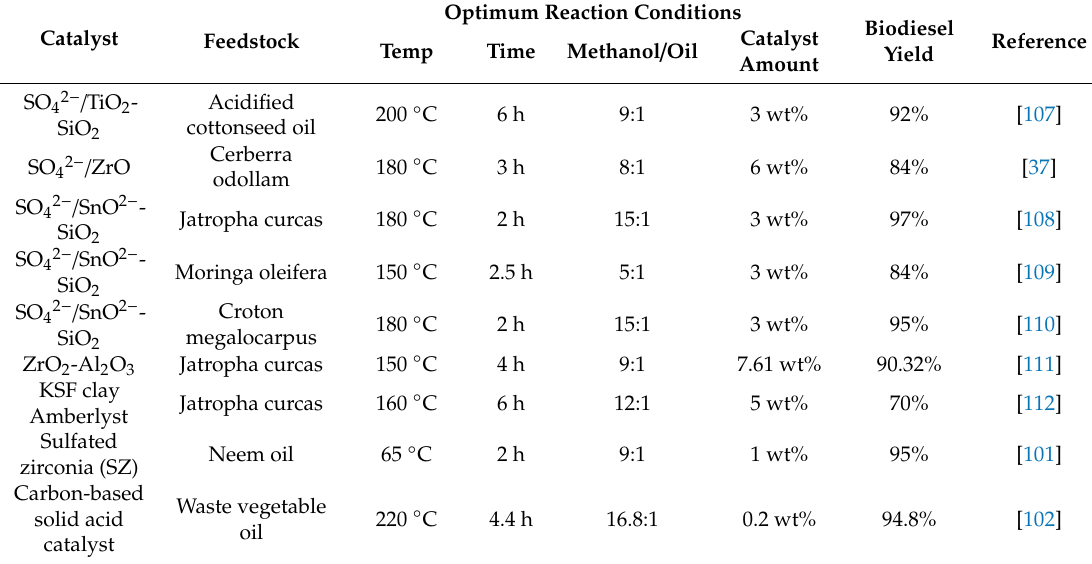
Table 2. Acidic solids as catalysts for transesterification